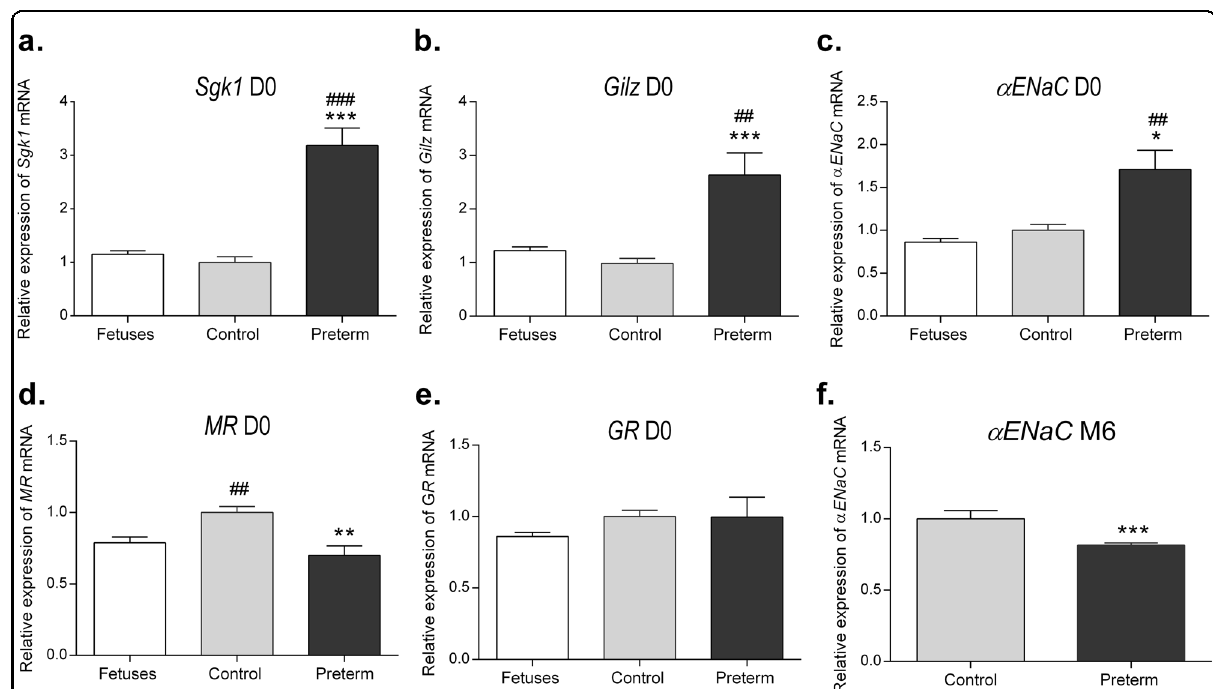
Fig. 4 Expression of major players in renal corticosteroid signaling pathways in premature mice compared to controls and fetuses. Relative renal mRNA expression of Sgk1 ( a ) , Gilz ( b ) , α ENaC ( c ), MR ( d ), and GR ( e ) at birth. Relative renal α ENaC mRNA expression ( f ) in former premature and control male mice at 6 months of age (M6). Relative mRNA expression in mice was determined using reverse transcription-quantitative PCR (RT- qPCR). The results are expressed as the ratio of attomoles of speci fi c gene per attomoles of ribosomal r18S RNA in E18.5 fetuses and D0 mice, or the ratio of attomoles of speci fi c gene per the geometric mean of three housekeeping genes ( 36B4 , beta actin and HPRT1 ) in M6 mice, normalized to the expression of control mice, arbitrarily set at 1. n = 6 mice in each group. * P < 0.05, ** P < 0.01, *** P < 0.001 (compared to the control group); # P < 0.05, ## P < 0.01, ### P < 0.005 (compared to the fetus group). Nonparametric Mann – Whitney U-